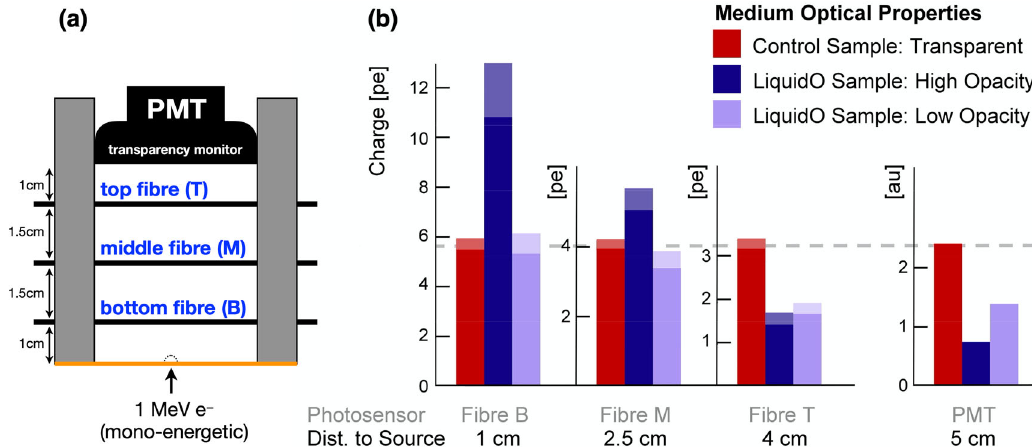
Fig. 3 Experimental proof of principle. a Diagram of the small prototype detector built to make the fi rst experimental demonstration of our opaque scintillator detection concept. The detector consists of a small cylindrical vessel with internally re fl ecting surfaces including a 25 μ m aluminised Kapton sheet at the bottom. Light is collected with three fi bres ( ϕ = 1 mm) running diametrically at different heights. A 3" photo-multiplier tube (PMT) is placed at the top and serves as a transparency monitor. Mono-energetic 1 MeV e − ’ s impinge from the bottom and make point-like energy depositions inside the detector as shown by the dashed semi-circular line. b The data collected with three scintillators made from the same base of Linear-Alkylbenzene (LAB) plus a PPO wavelength-shifter at 2 g l − 1 are shown with measurement uncertainties illustrated by the pale regions at the top of each bar. These uncertainties correspond to the standard deviation of up to 10 measurements for each sample. The high (dark blue) and low (light blue) opacity formulations are obtained by mixing in a paraf fi n polymer at 10% and setting the temperature at 12 °C and 26 °C, respectively. The measurements from the prototype obtained with the opaque formulations are compared with those from the transparent scintillator (red), which serves as a control sample. To allow relative changes in light collection between the three fi bres and the PMT to be seen easily, the axes of each bar chart were scaled so that the red bars are all the same height (grey dashed line). The high opacity data show a clear increase (around 2.0×) at the bottom of the vessel and a decrease (around 0.5×) at the top, as expected from stochastic light con fi nement around the energy deposition point. Given that the low and high opacity samples have the same composition and differ only in temperature, these results show that the formation of a light-ball and the corresponding increase in light collection at the bottom fi bre are directly linked to the shorter scattering